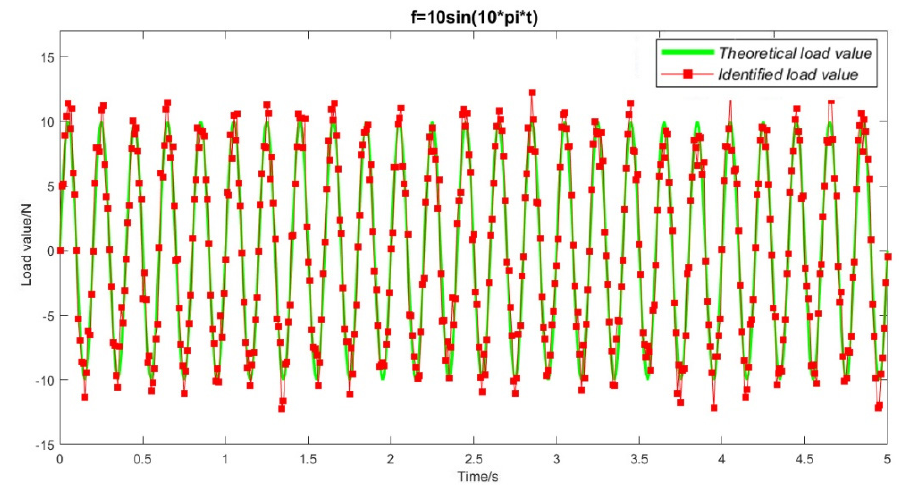
Figure 13. Identification results.